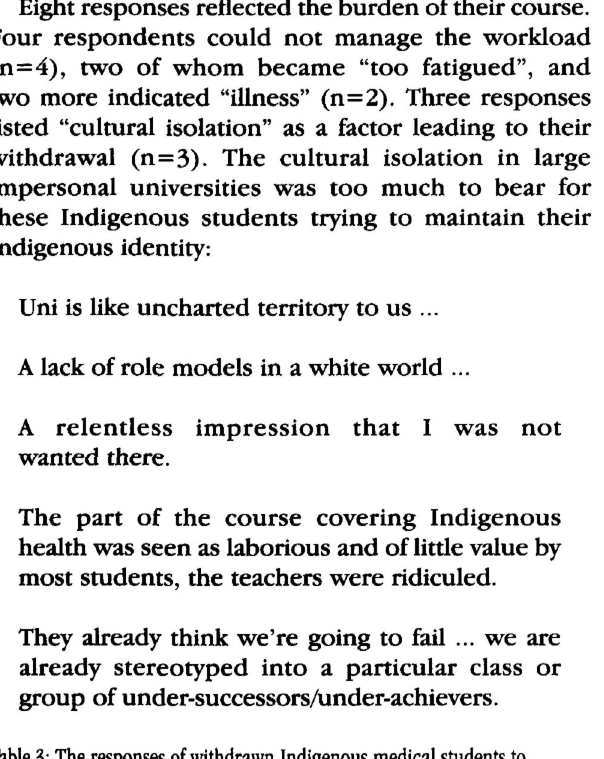
Table 3: The responses of withdrawn Indigenous medical students to Question 3: What would have encouraged you to continue?